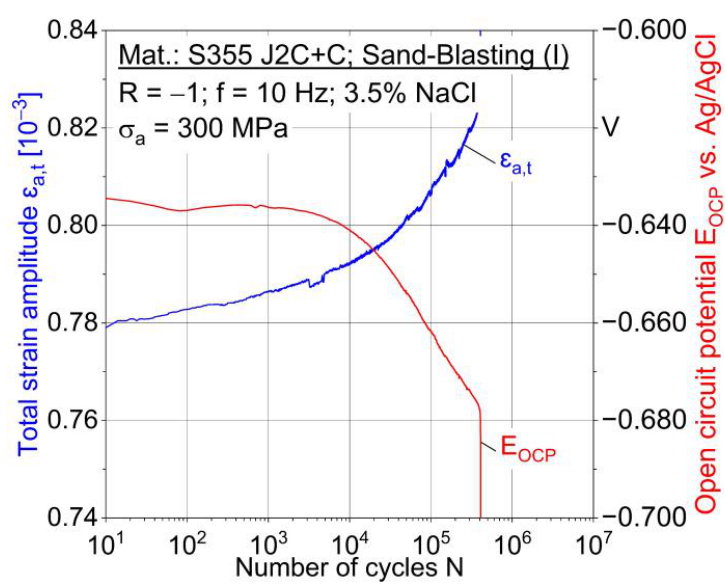
Figure 9. Corrosion fatigue tests of sandblasted (I) specimens in 3.5% NaCl solution.